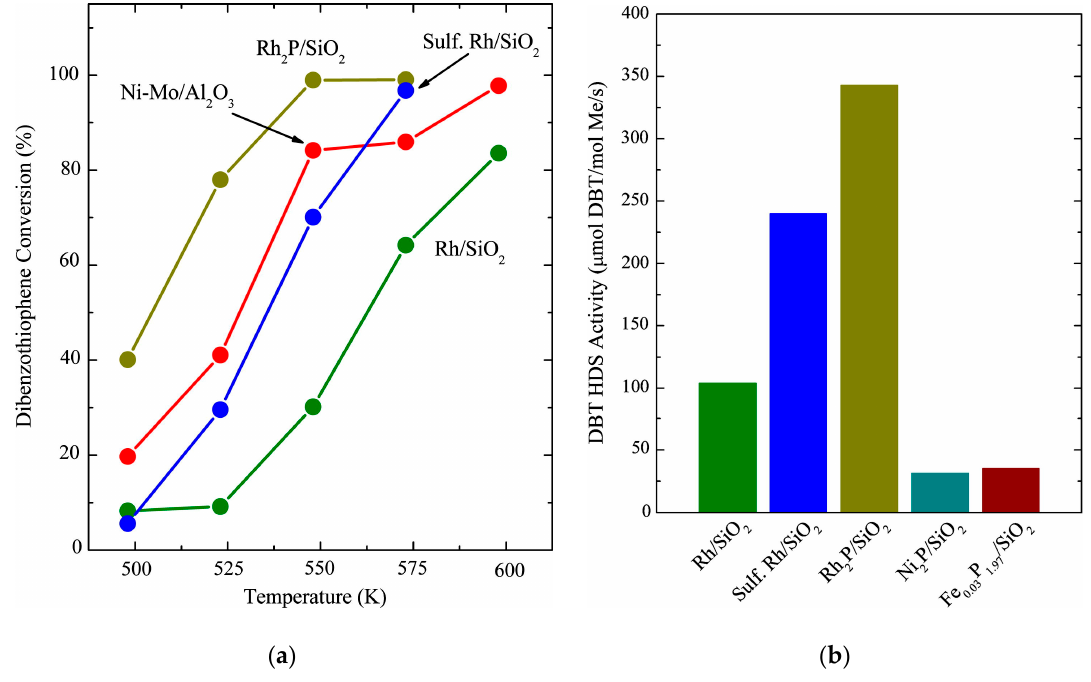
Figure 3. Results of the catalyst testing by Hayes et al.: ( a ) Performance of the different catalyst materials; ( b ) Normalized dibenzothiophene (DBT) activity of different catalyst materials. Printed with permission of [27]. Table 3. Comparison of the performance of different catalysts in the hydrodesulfurization (HDS) of dibenzothiophene (DBT) in the investigation of Hayes et al. [9] (275 ◦ C, 3.0 MPa, 3000 ppm HDS in